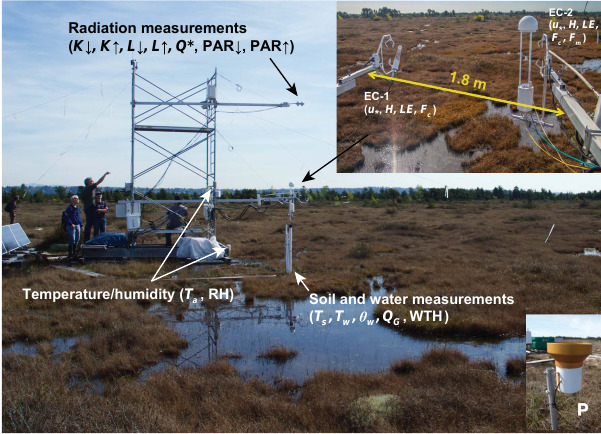
Figure 1. Flux tower on floating platform with EC-1 and EC-2 systems facing south and instruments that measured climate vari- ables indicated (friction velocity ( u ∗ ) , sensible heat flux ( H) , latent heat flux (LE), CO 2 flux (NEE), CH 4 flux ( F m ) , incoming short- wave radiation ( K ↓ ) , outgoing shortwave radiation ( K ↑ ) , incom- ing longwave radiation ( L ↓ ) , outgoing longwave radiation ( L ↑ ) , net all-wave radiation ( Q ∗ ), incoming PAR (PAR ↓ ) , outgoing PAR (PAR ↑ ) , air temperature ( T a ) , relative humidity (RH), soil temper- ature ( T s ) , water temperature ( T w ) , soil water content ( θ w ) , soil heat flux ( Q G ) , water table height (WTH), and precipitation ( P